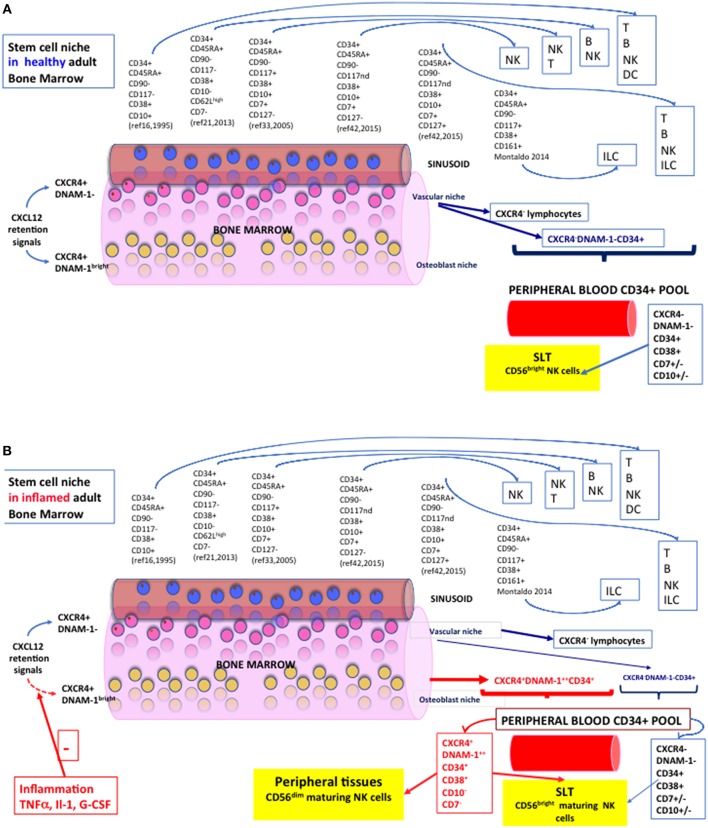
NK cell hematopoiesis in health and during systemic inflammation. A section of Bone Marrow with a sinusoid is represented. Vascular Niche in pink, osteoblast niche representation in yellow. Blue cells represent CXCR4- lymphoid or erythroid cells passively released in the sinusoid. A spectrum of the phenotypes of so far characterized CD34+ NK cell precursors is represented with reported progenies and is indicated by citation numbers. (A) Diagram of the Stem Cell Niche and NK cell precursors in Healthy Adult Bone Marrow. Lymphoid cells and precursors exiting passively from sinusoids are indicated by dark blue arrows and constitute the pool of CD34+ cells circulating in peripheral blood. A yellow box defines their trajectory toward SLT (CD62L+CCR7+) and the prevailing phenotype of NK cells grown under standard conditions in vitro. (B) The Stem Cell Niche and CD34+ NK cell precursors in Adult Bone Marrow during chronic inflammation. During chronic inflammation, inflammatory cytokines and mediators determine a reduction/shutdown of CXCL12 signaling within the BM niches, with decreased retention ability of CXCR4+ HSC and CLP that otherwise populate the BM but do not circulate in PB. Red arrows show “inflammatory” or “emergency” CD34+ cells exting the BM. A different composition of CD34+ peripheral blood pool is accordingly shown during inflammatory conditions (HIV, HCV, COPD, Tuberculosis, PAPA). Travel trajectories of Lin−CD34+DNAM-1brightCXCR4+ cells toward peripheral tissues are shown as these CD34+ CLPa express CX3CR1+, CXCR1+, CXCR3+, in addition to SLT-homing receptors (CD62L+CCR7+).